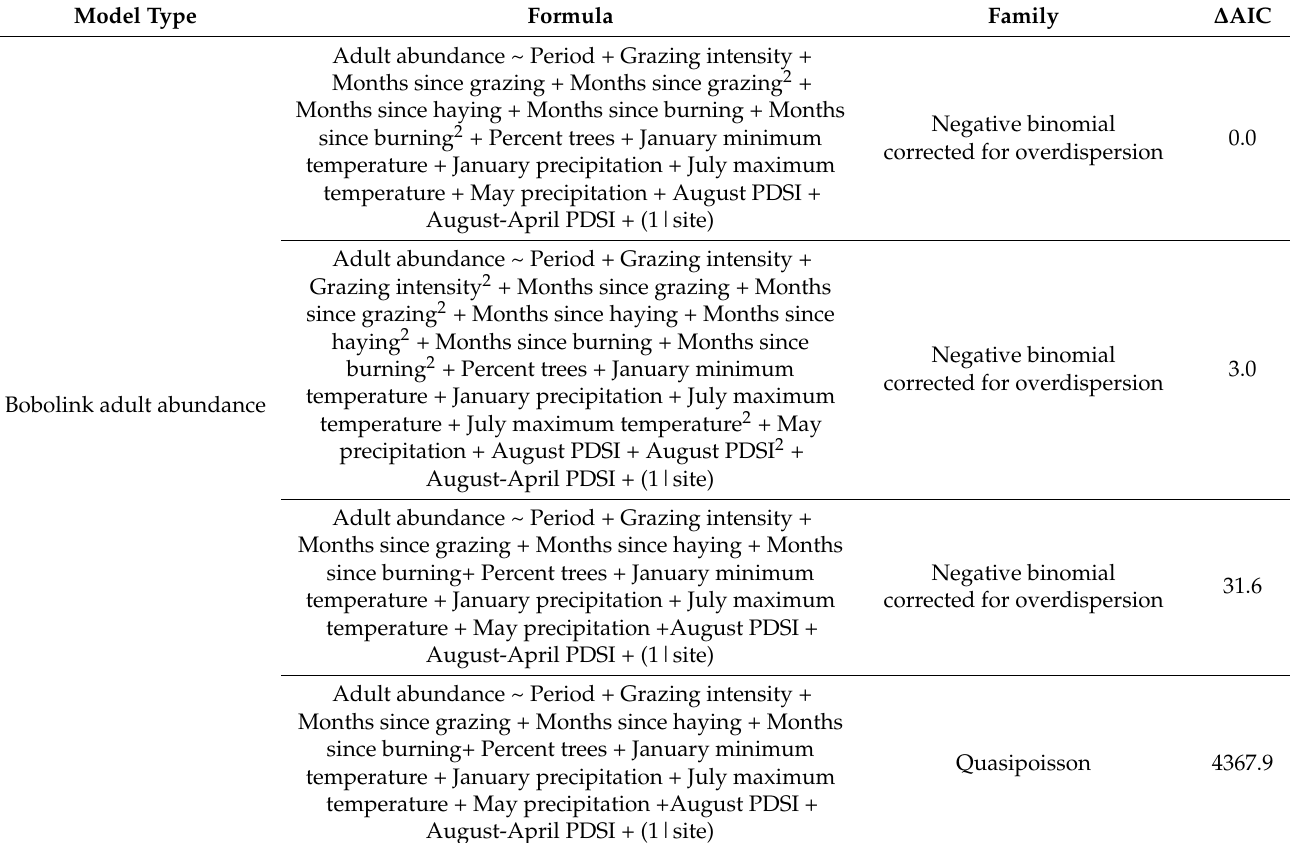
Table 3. Bobolink adult and juvenile AIC model results from generalized linear mixed models testing land management and/or climate predictors of changes in Bobolink abundance and